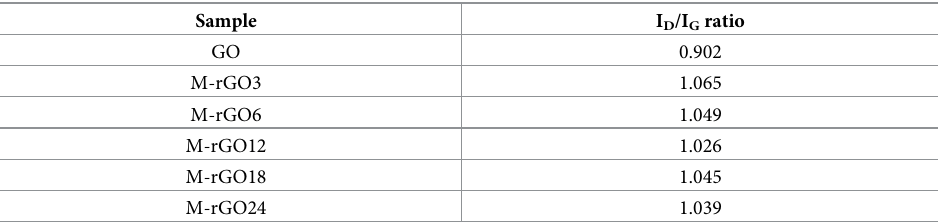
Table 3. Degree of disorder (I D /I G ) of GO and